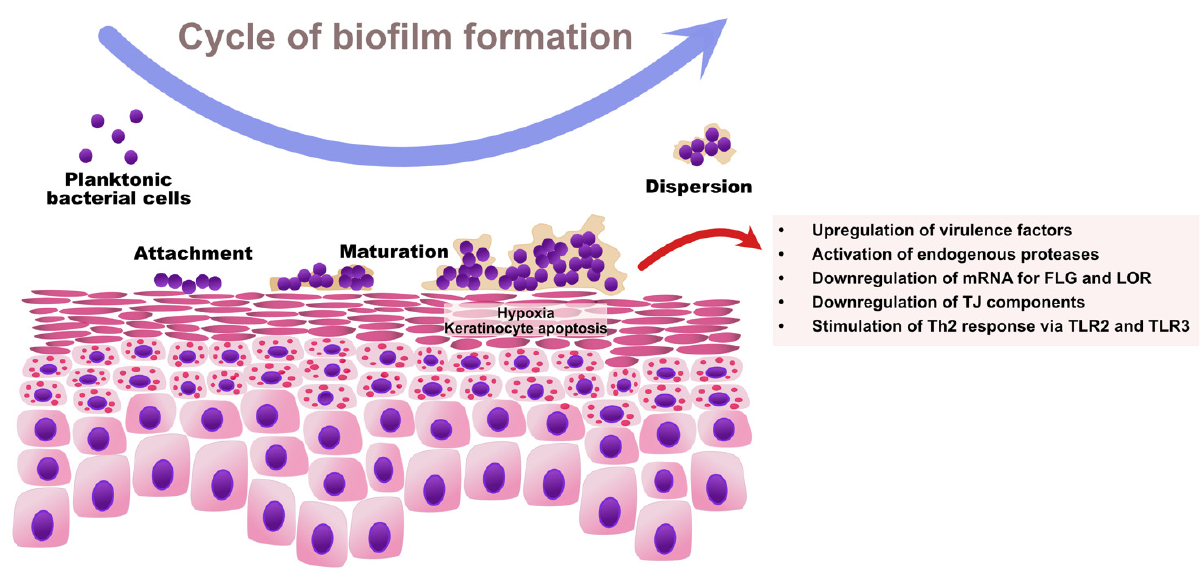
Figure 2. The cycle of S. aureus biofilm formation and its impact on skin barrier function in AD. The increased expression of adhesion molecules, epidermal lipid aberrations, and paucity of AMPs predispose AD patients to S. aureus colonization. Initially, planktonic S. aureus cells adhere to the skin surface via microbial surface components recognizing adhesive matrix molecules (MSCRAMMs) and start producing extracellular polymeric substances (EPS), which results in the establishment of a bacterial community associated in the biofilm. The growing biofilm causes hypoxia and the apoptosis of keratinocytes. Once the bacterial quorum is achieved, the Agr system activates the upregulation of virulence factors including proteases and toxins, and the downregulation of colonization and adhesion molecules with the dispersal of biofilm to new locations. Collectively, S. aureus biofilm contributes to the destruction of the epidermal barrier by downregulating EDC proteins and TJ components, and by stimulating Th2-skewing as a result of aberrant innate immune response. FLG—filaggrin; LOR—loricrin.